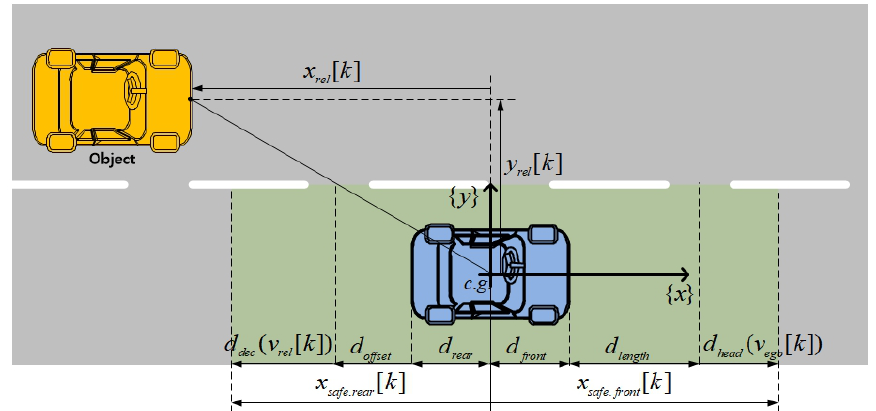
Figure 2. Definition of vehicle